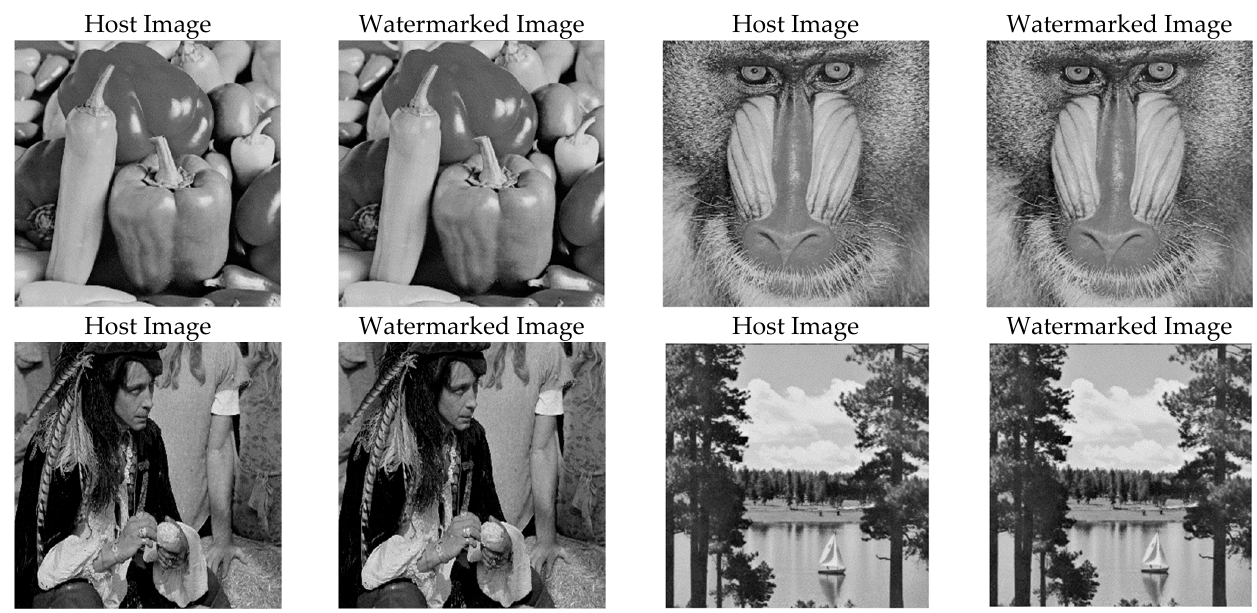
Figure 8. Original images and corresponding watermarked images. The PSNR (dB) values of the resulting watermarked images are 46.8532, 45.6986, 52.7633, 46.7466, for the pepper, baboon, pirate and sailboat, respectively.